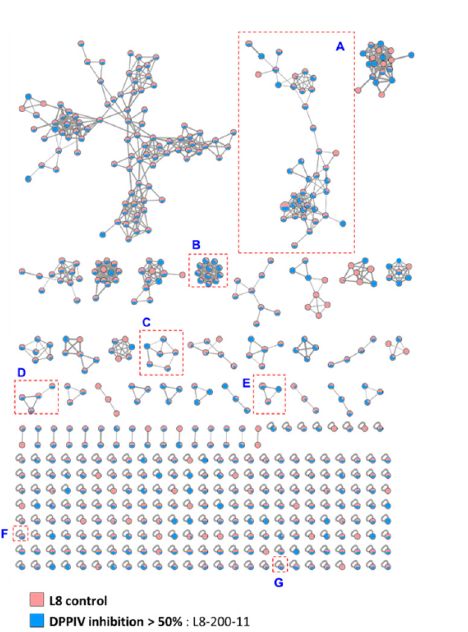
Figure 1. Feature-based molecular networking of lentil samples: ( a ) an entire molecular network of L8 control and L8-200- 11 (most active sample); ( b ) targeted cluster annotation for the active lentil mutant lines extracts; ( c ) annotated molecular node by the comparison of Global Natural Product Social Molecular Networking library.